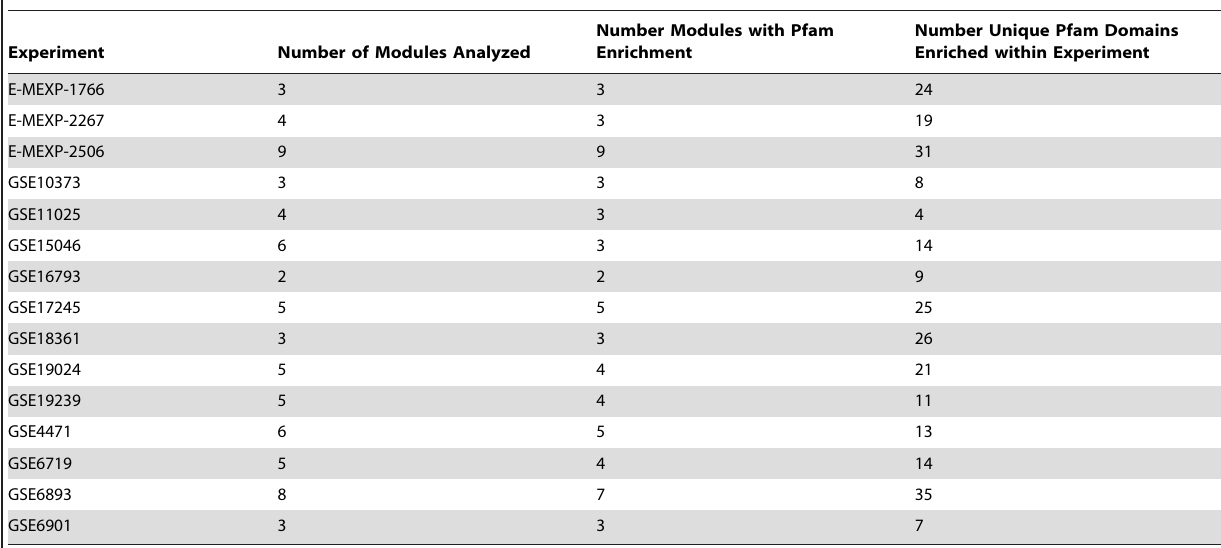
Table 4. Number of gene coexpression modules and number of enriched Pfam domains associated with different experiments.